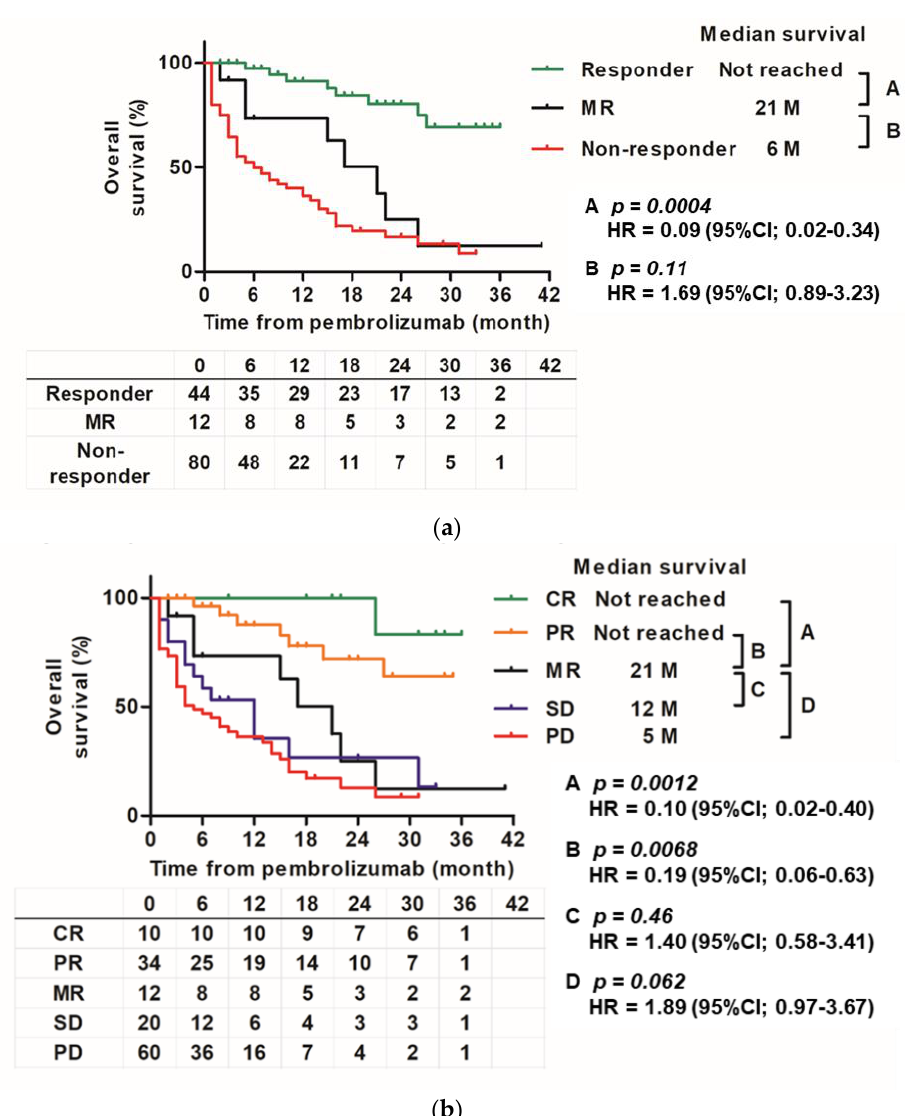
Figure 5. Kaplan–Meier curve for each objective response group. ( a ): Kaplan–Meier estimates of overall survival according to three groups (responder, MR, and non-responder groups) from the start of pembrolizumab treatment to the date of death by any cause. ( b ): Kaplan–Meier estimates of overall survival for five groups (CR, PR, MR, SD, and PD) from the start of pembrolizumab treatment to the date of death by any cause.